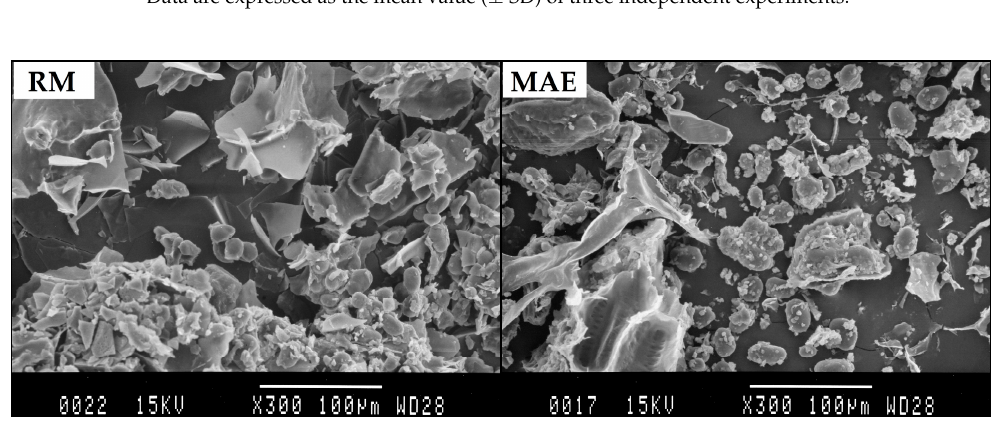
Figure 3. Left, a scanning electron microscopy image of a sample of raw material (RM) and right, the sample processed by MAE.